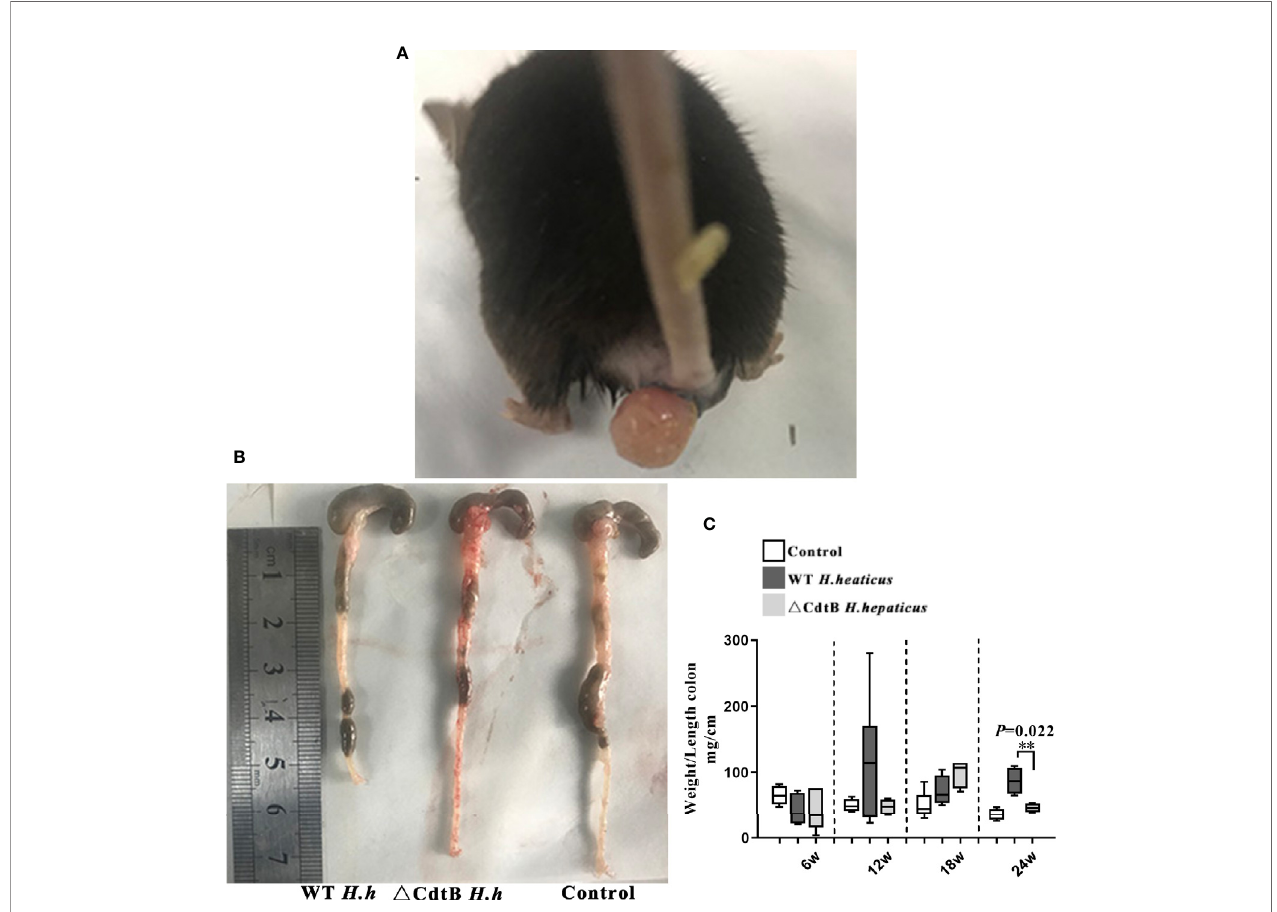
FIGURE 2 | Deletion of CdtB alleviated colitis symptoms induced by ( H ) hepaticus infection. (A) Rectocele of mice in H. hepaticus group; (B) colonic segment of the experimental groups at 24 w; (C) weight/length ratio of the colon; Data are expressed as the mean ± SEM (n = 5/group). **represents P values <0.01 compared with the control